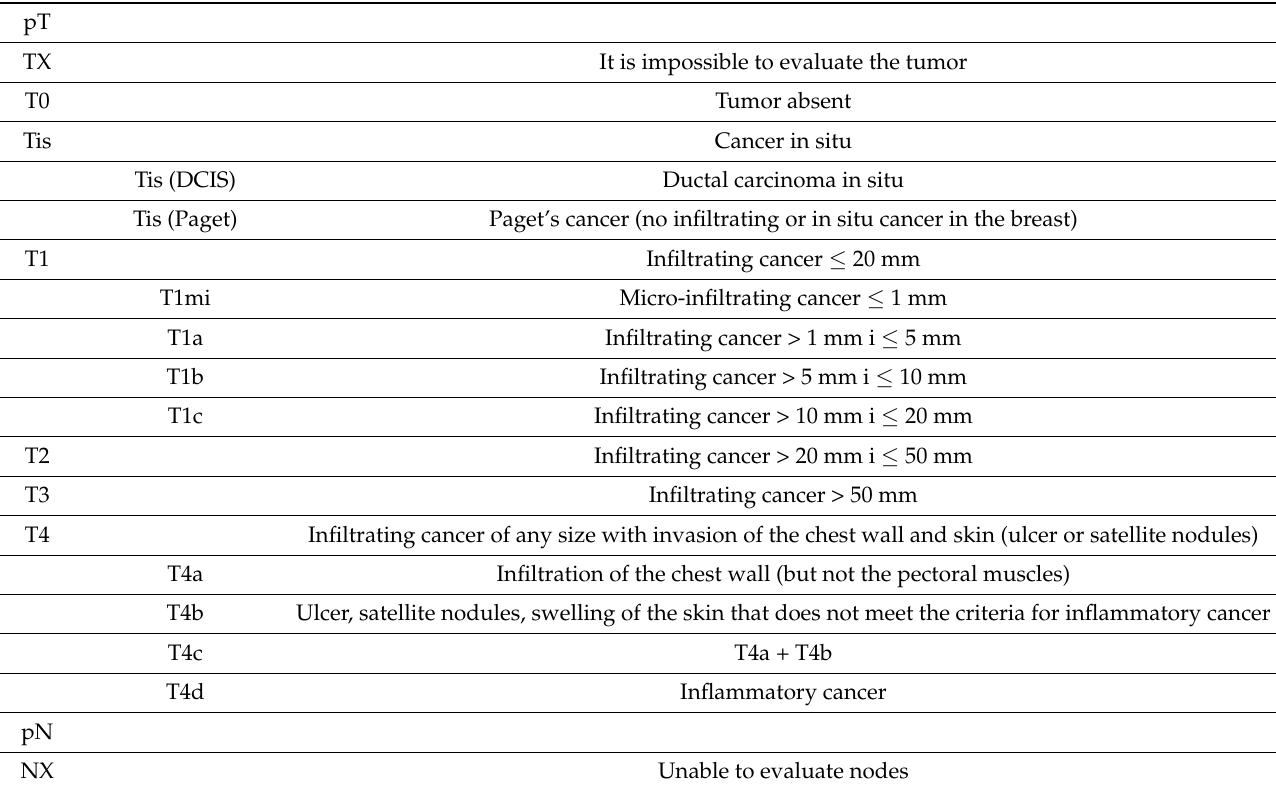
Table 4. VIII edition of the pTNM